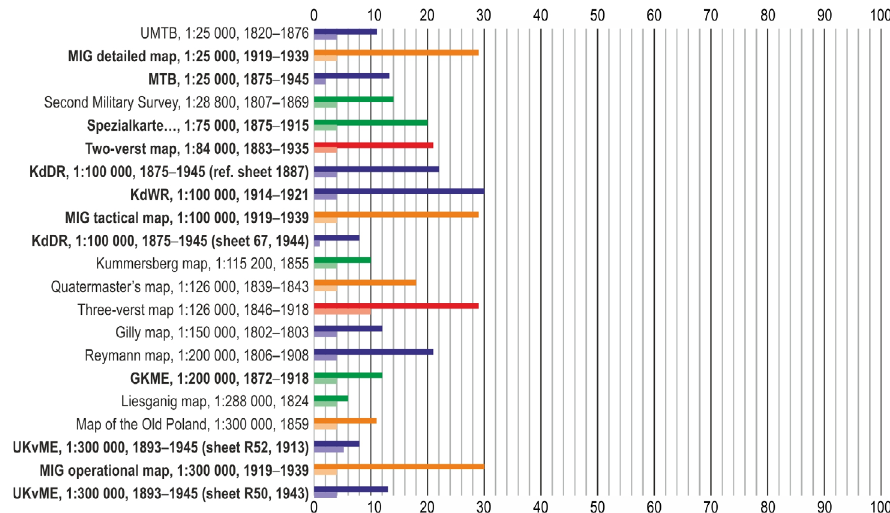
Fig. 7. Number of feature types on different maps’ key to symbols among “administrative units” feature class category (before and after harmonization)